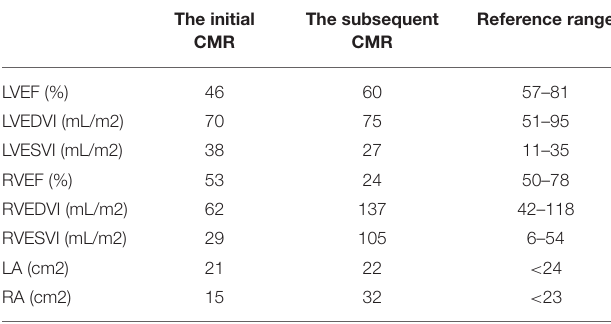
TABLE 2 | Comparison of CMR results during two separate hospitalizations.